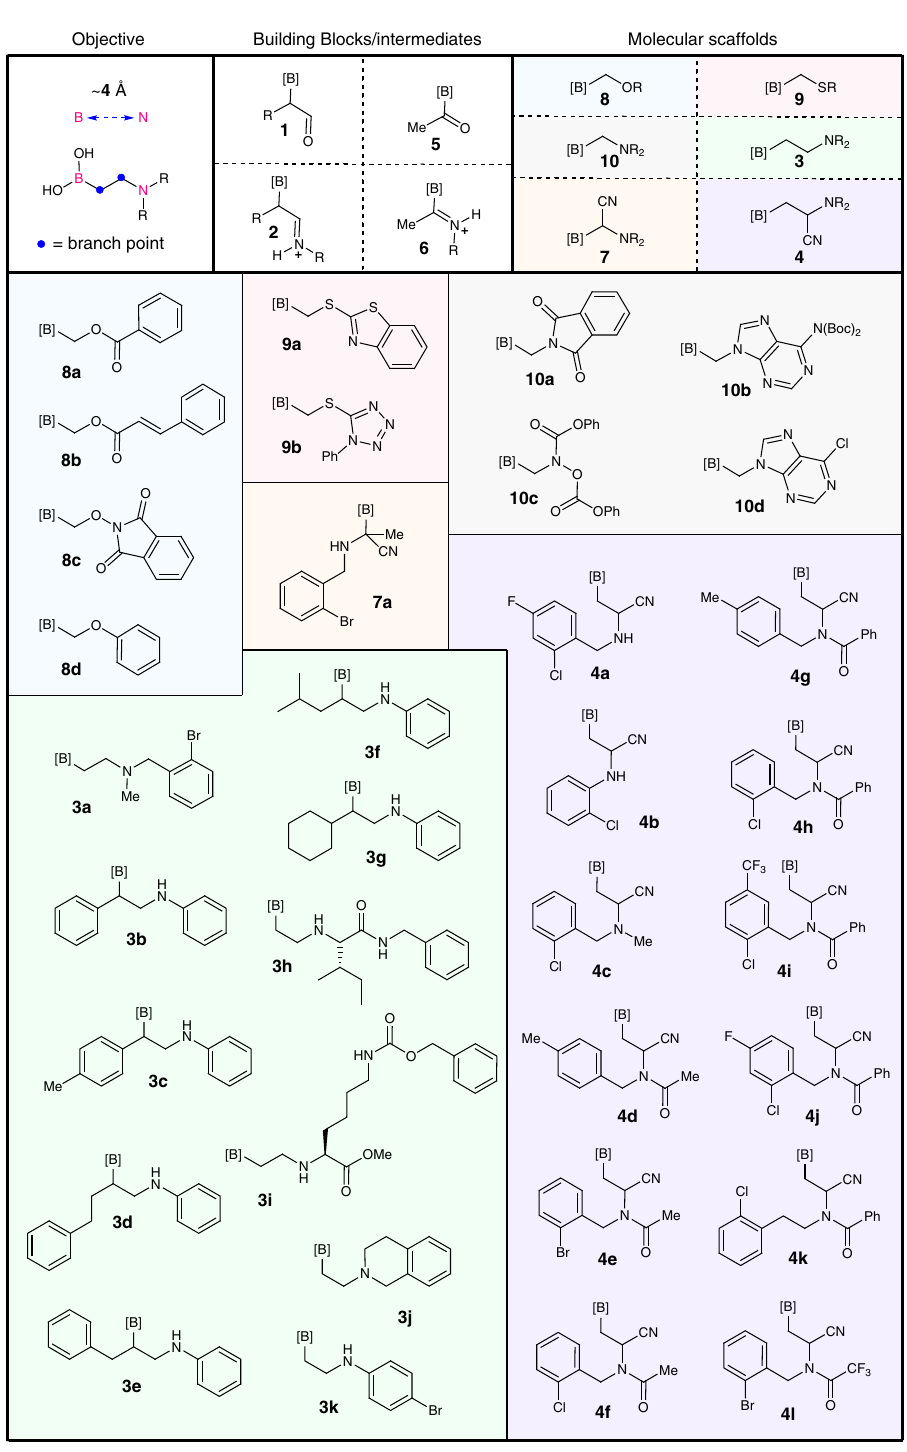
Fig. 3 MIDA boronate library synthesized and screened for biological activity. An overview of our overall goal, building blocks used, molecular scaffolds we have developed and the respective compounds synthesized in this study. Each panel represents a different chemical reaction and a speci fi c chemotype. The molecules within each panel expand on that